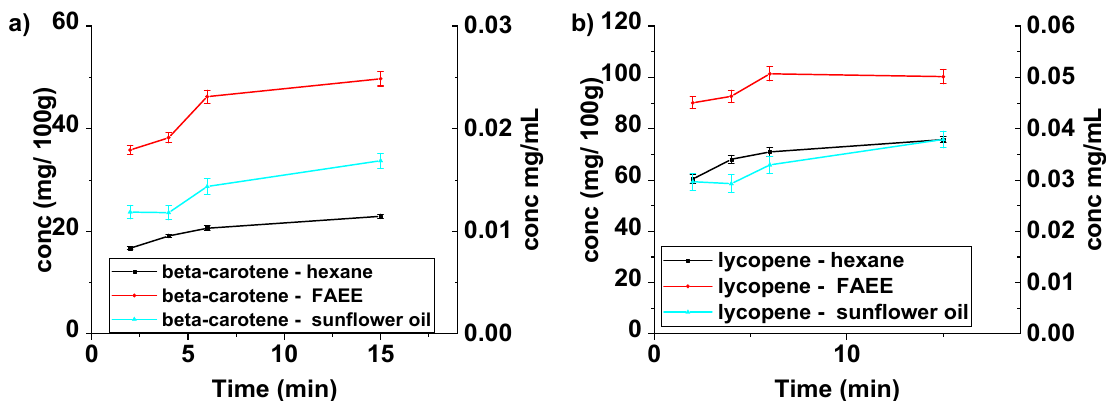
Figure 4. Beta-carotene ( a ) and lycopene ( b ) concentrations (mg carotenoid/100 g dry plant (left y-axis) and mg carotenoid/mL solvent (right y-axis)) during extraction experiments from Pontica 102 skins in different solvents, under conventional conditions at 60 ◦ C.